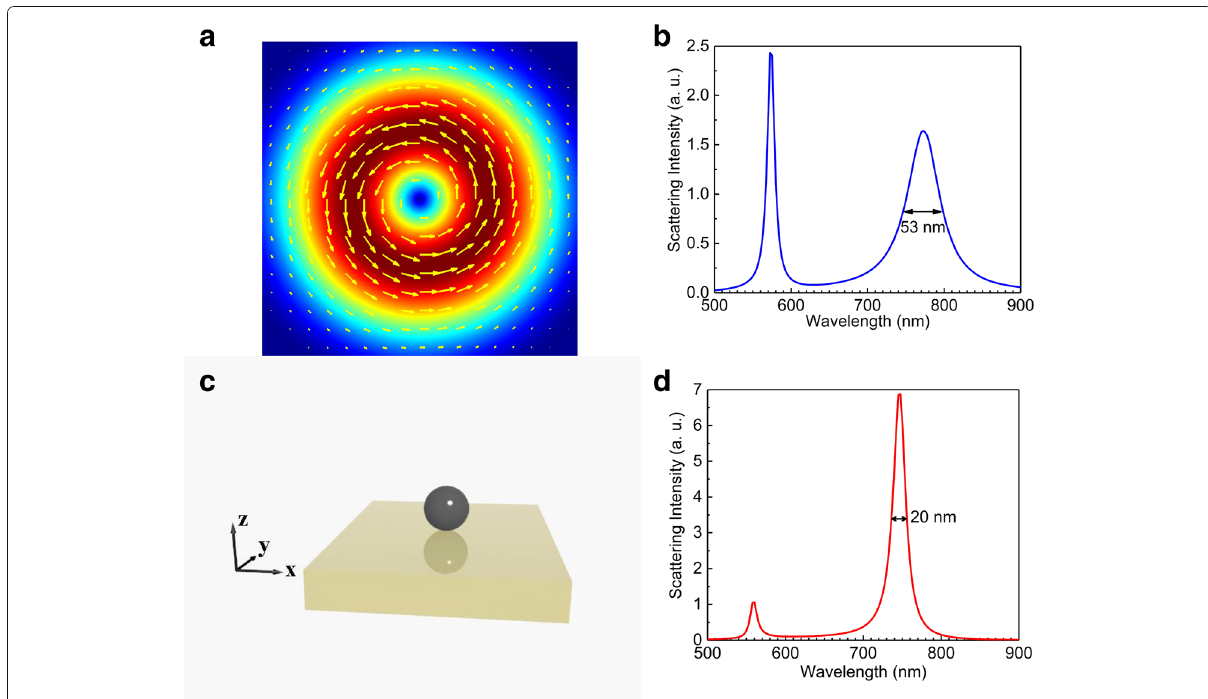
Fig. 1 a The electric field distribution of a focused AP beam at the focal point. b The scattering spectrum of the Si NS suspended in air. The line width of the MD resonance is 53 nm. c The Si NS with R = 100 nm placed on a metal substrate. d The scattering spectrum of the Si NS placed on a PEC